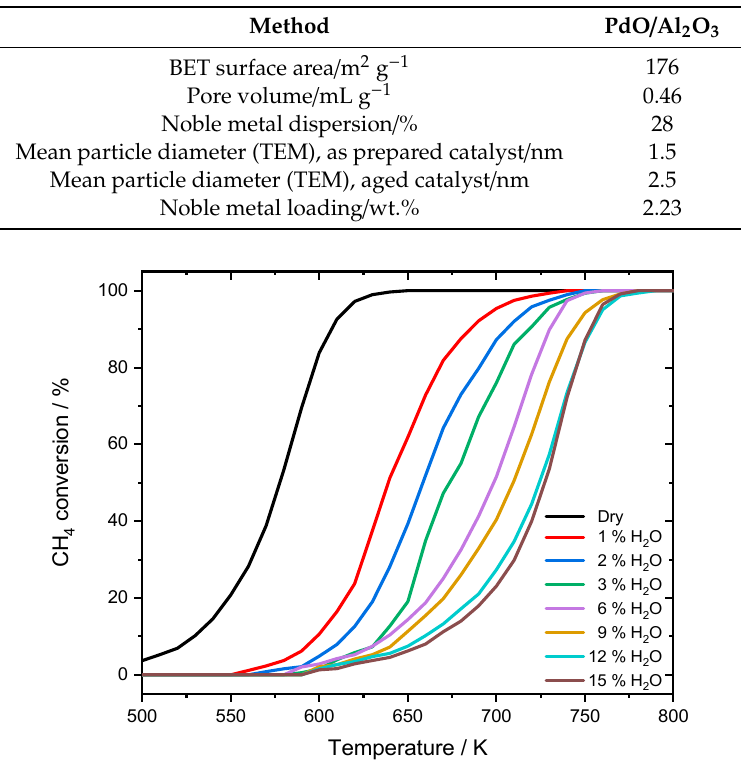
Figure 1. Di ff erent light-o ff measurements for PdO / Al 2 O 3 in 3200 ppm CH 4 , 10% O 2 and balance N 2 in the absence of steam and in the presence of di ff erent water concentrations, with a temperature ramp of Figure 1. Different light-off measurements for PdO/Al 2 O 3 in 3200 ppm CH 4 , 10% O 2 and balance N 2 3 K min − 1 . GHSV = 140,000 h − 1 in the absence of steam and in the presence of different water concentrations, with a temperature ramp of 3 K min − 1 . GHSV = 140,000 h − 1 .